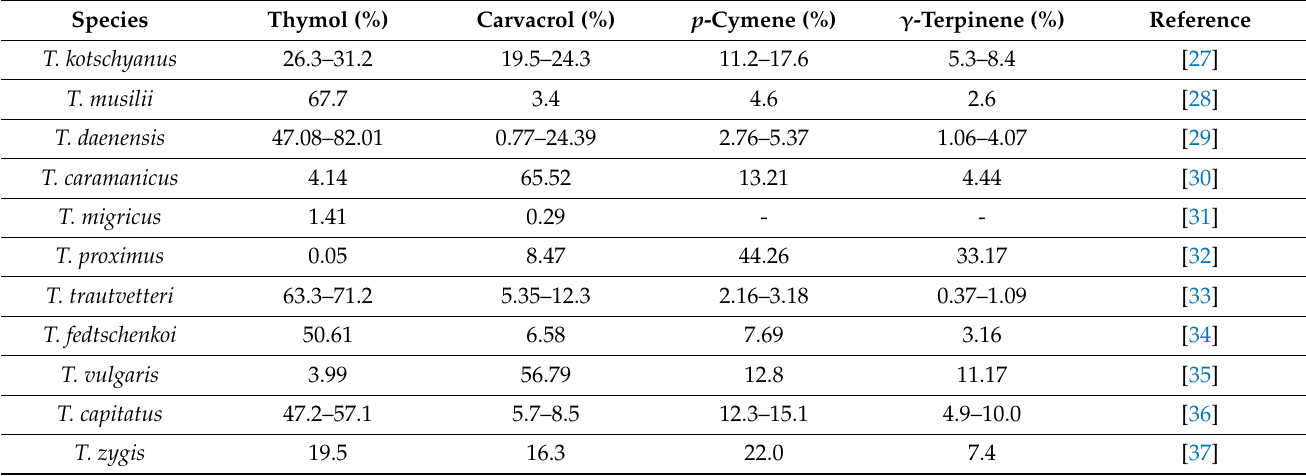
Table 6. Comparison of individual compounds in volatile oils of Thymus